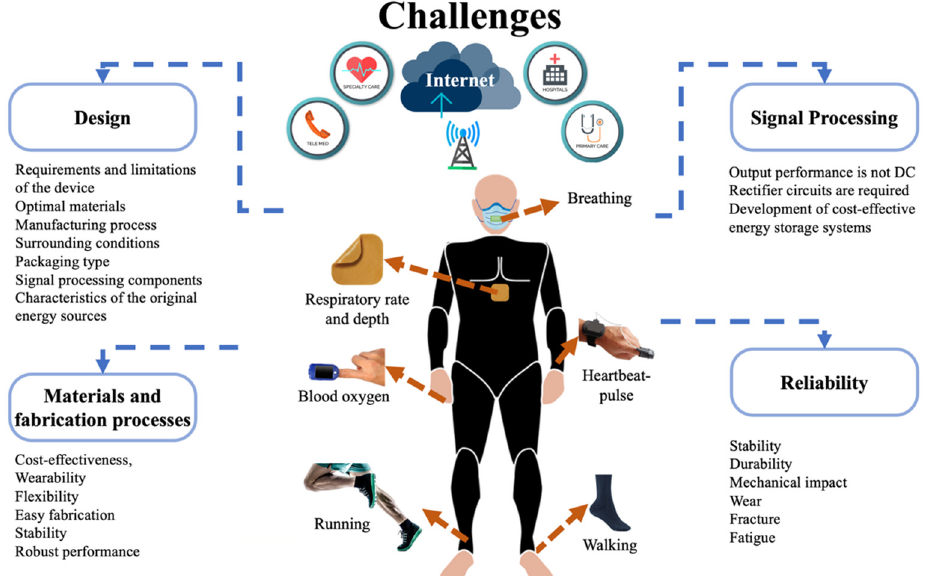
Figure 29. Summary of challenges of piezoelectric and triboelectric nanogenerators in IoMT electronic devices.